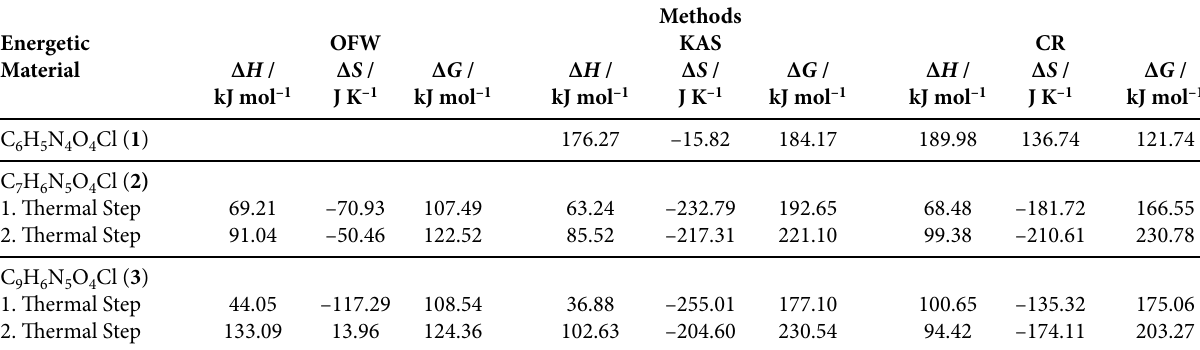
Table 6. The calculated thermodynamic values of the energetic materials prepared for the thermal decomposition